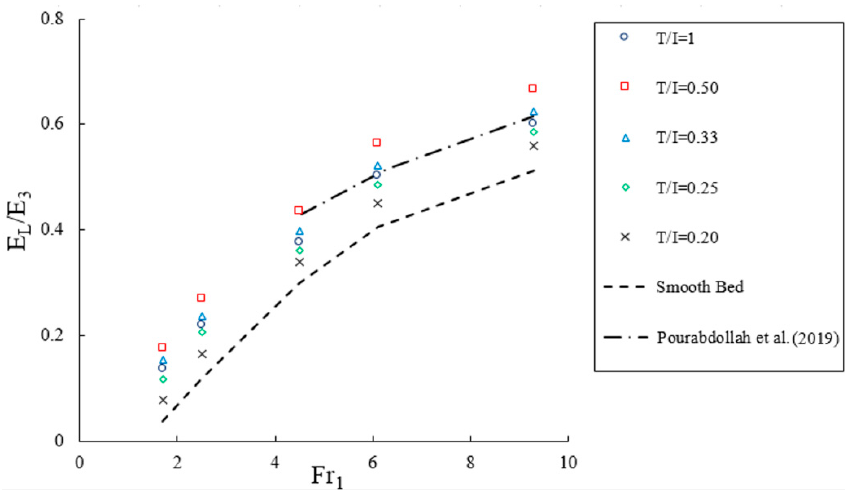
Figure 18. The energy loss ( E L /E 3 ) of the submerged jump versus inlet Froude number ( Fr 1